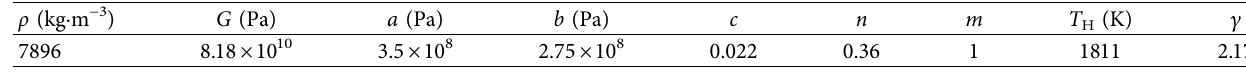
Table 3: The parameters of the slit pipe material.